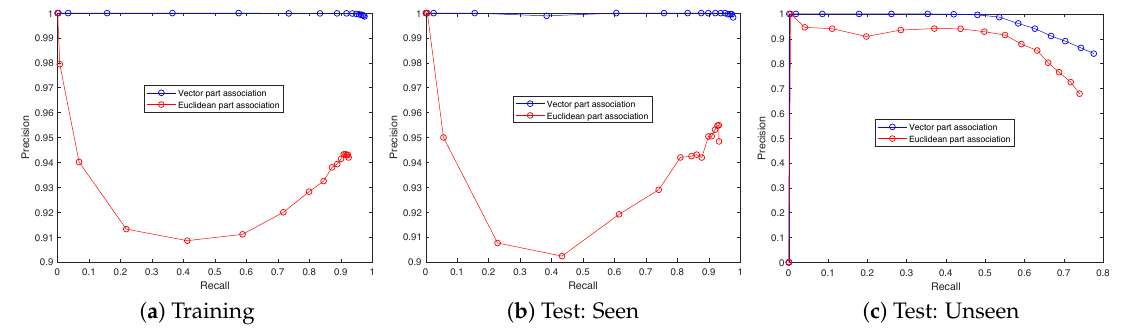
Figure 10. Precision-recall curves for both the proposed method and an alternative association strategy that assigns parts to one another by minimizing Euclidean distance. The results are nearly identical across the training set ( a ) and test:seen set ( b ), and both illustrate a dramatic improvement achieved by joining parts together using the proposed vector mapping. The results on the test:unseen set ( c ) illustrate the limitations of the method when operating on different environments than those used for training. Table 4. Detailed results obtained with the proposed method and an alternative association strategy that assigns parts to one another by minimizing Euclidean distance. The table includes true positives (TP), false positives (FP), false negatives (FN), precision, recall, and F-measure for different part detection